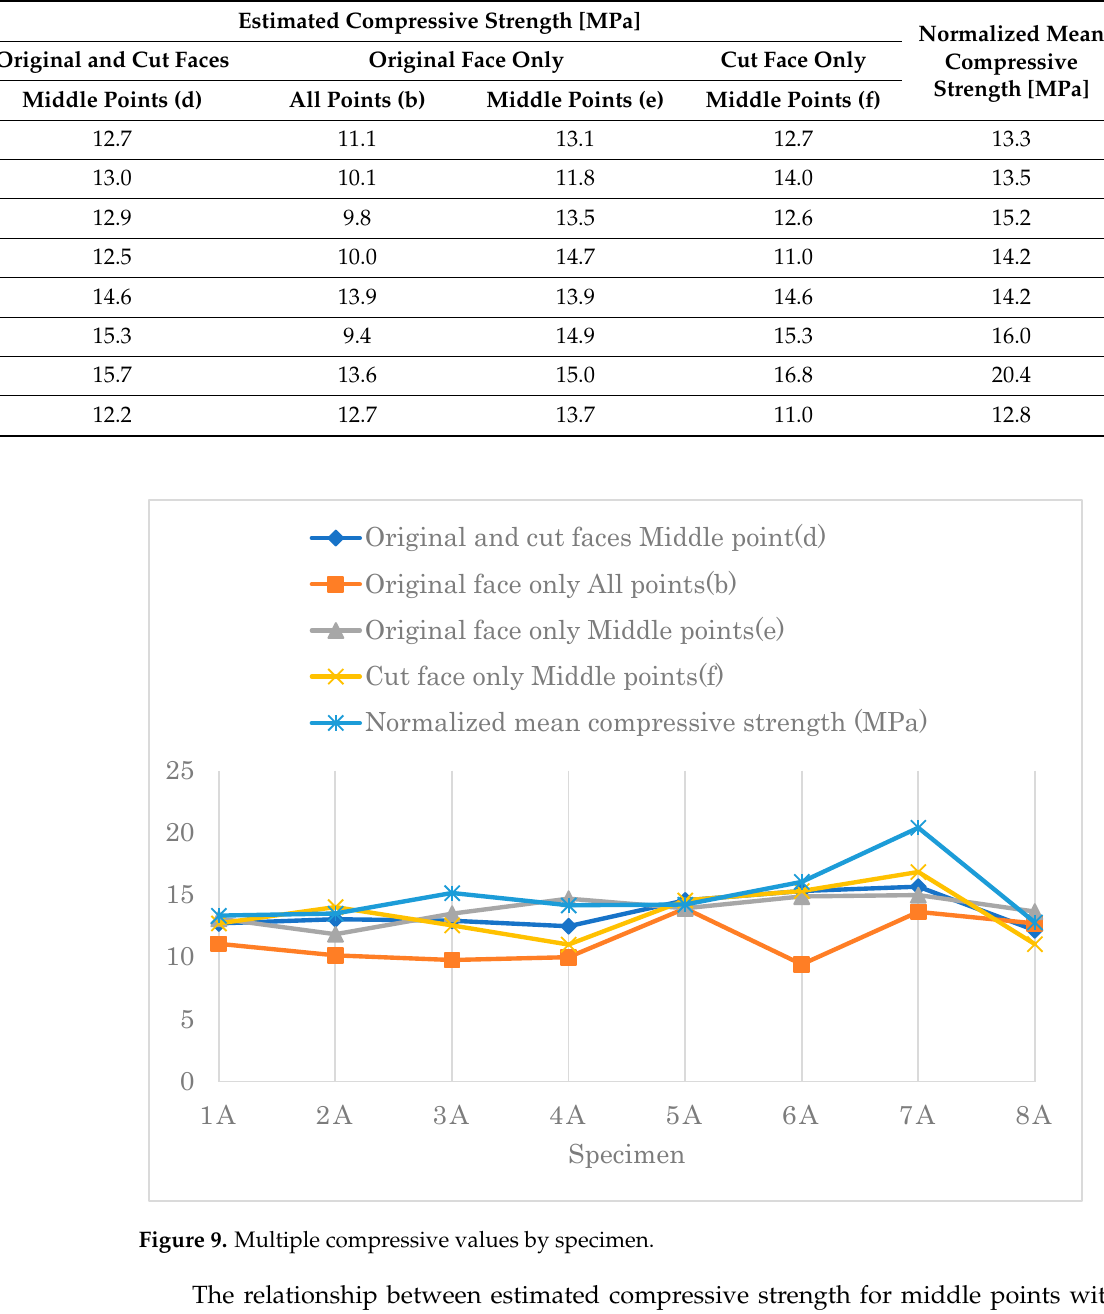
Table 8. Summary of the compressive strength results.